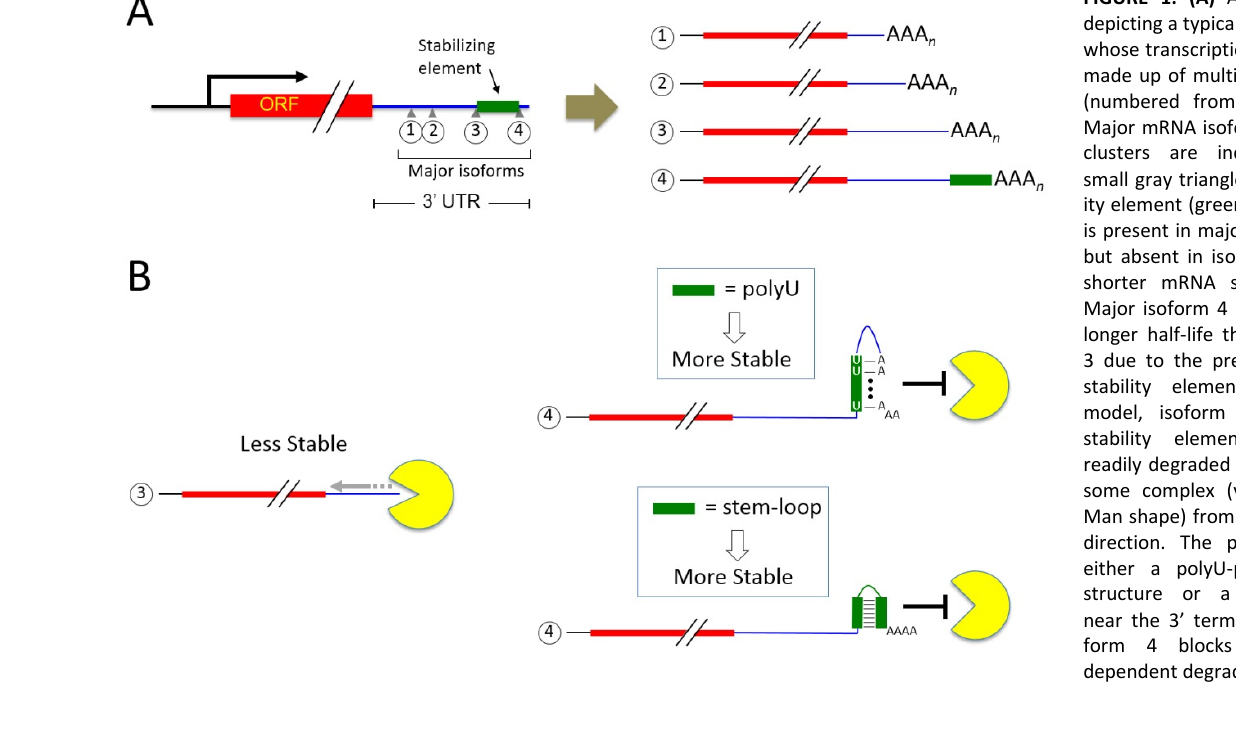
FIGURE 1: (A) A schematic depicting a typical yeast gene whose transcription profile is made up of multiple clusters (numbered from 5’ to 3’). Major mRNA isoforms within clusters are indicated by small gray triangles. A stabil- ity element (green rectangle) is present in major isoform 4 but absent in isoform 3 and shorter mRNA species. (B) Major isoform 4 possesses a longer half-life than isoform 3 due to the presence of a stability element. In this model, isoform 3 has no stability element and is readily degraded by the exo- some complex (yellow Pac- Man shape) from the 3’ to 5’ direction. The presence of either a polyU-poly(A) tail structure or a stem-loop near the 3’ terminus of iso- form 4 blocks exosome- dependent